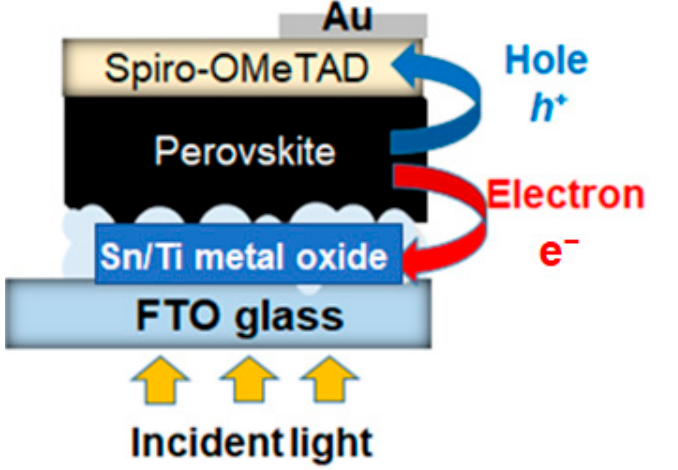
Figure 7. A device structure of the lead halide PSCs tested in this work. The ETL consists of a Sn/Ti oxide thin film (single layer) deposited on top of the FTO glass.